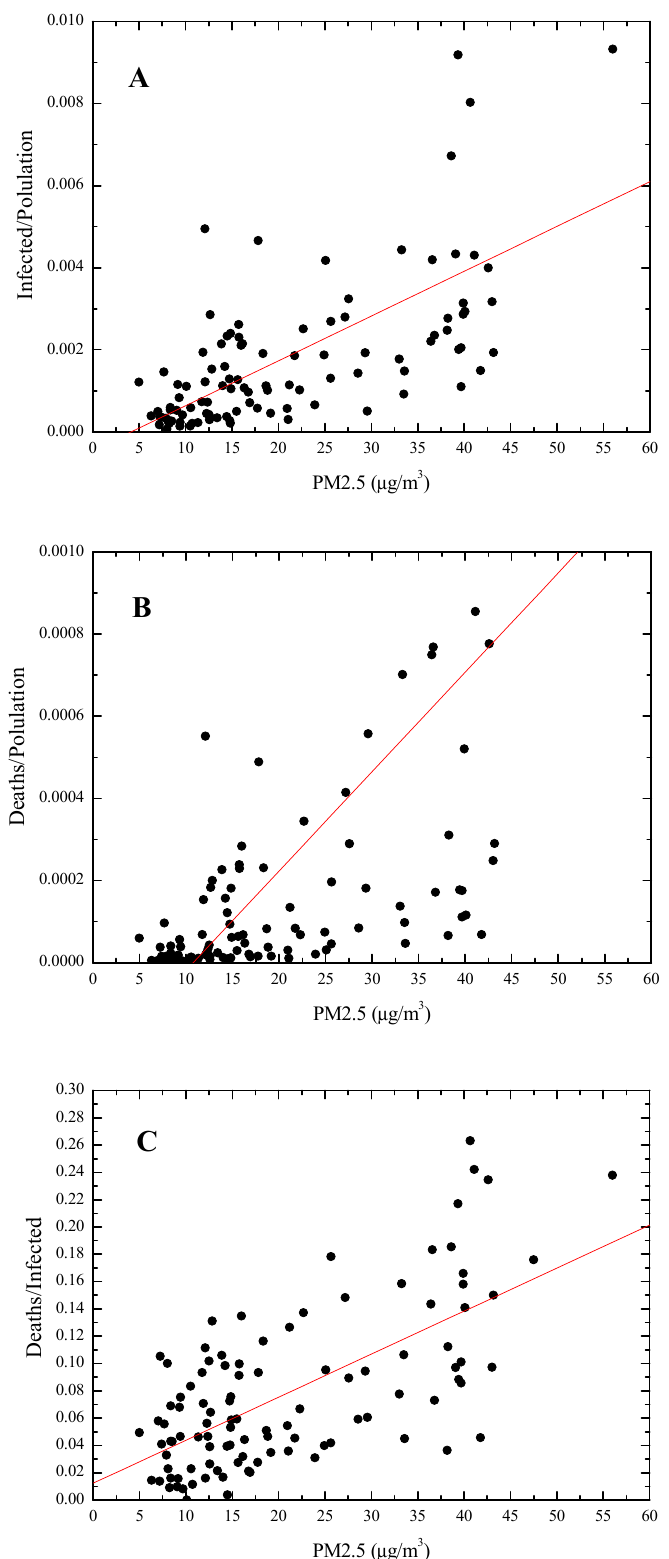
Figure 4. Linear regression analysis correlating the average PM 2.5 concentration values in the period 15–26 February 2020 with the incidence of the pathology ( A ), the mortality rate ( B ) and the case fatality rate ( C ) in the period 20 February–31 March 2020.